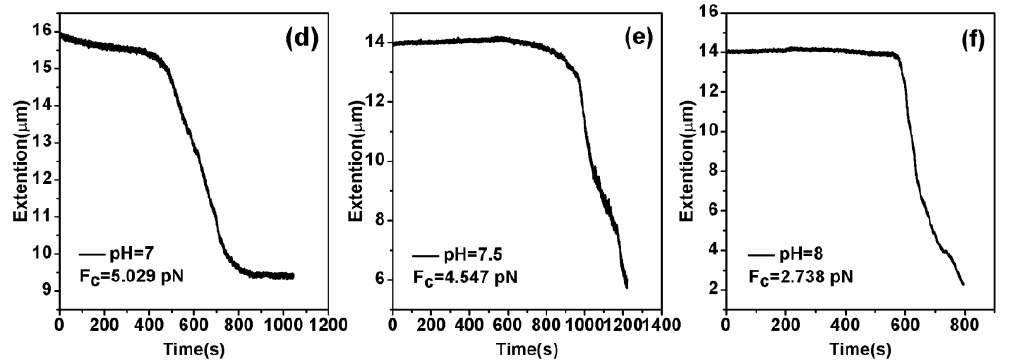
Figure 6. DNA extension as a function of pulling time. ( a ) – ( f ): The cases of different pHs (pH = 4.6, pH = 5.4, pH = 6, pH = 7, pH = 7.5 and pH = 8) with a fixed chitosan concentration 20 µM.